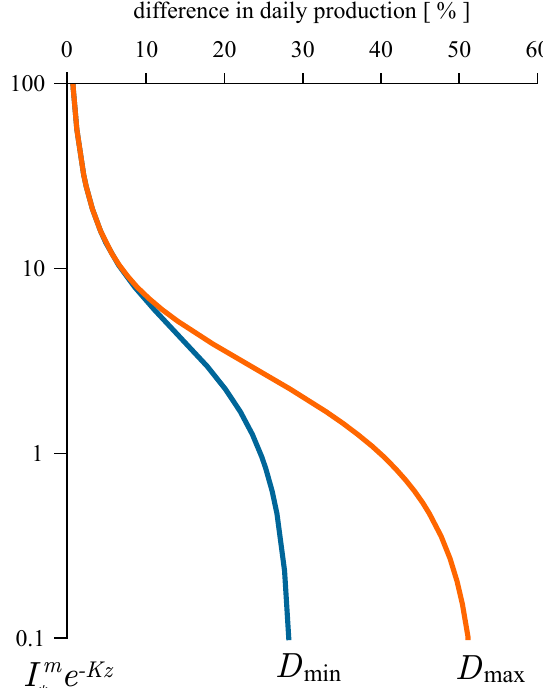
Figure 1. Percentage difference in daily production between the estimate based on linear extrapolation of average production during a six-hour interval around noon (5) and the analytical solution for daily production (6). The orange curve corresponds to the Julian day with the longest day length D max and the blue with the shortest day length D min , at the latitude of the Stonˇcica